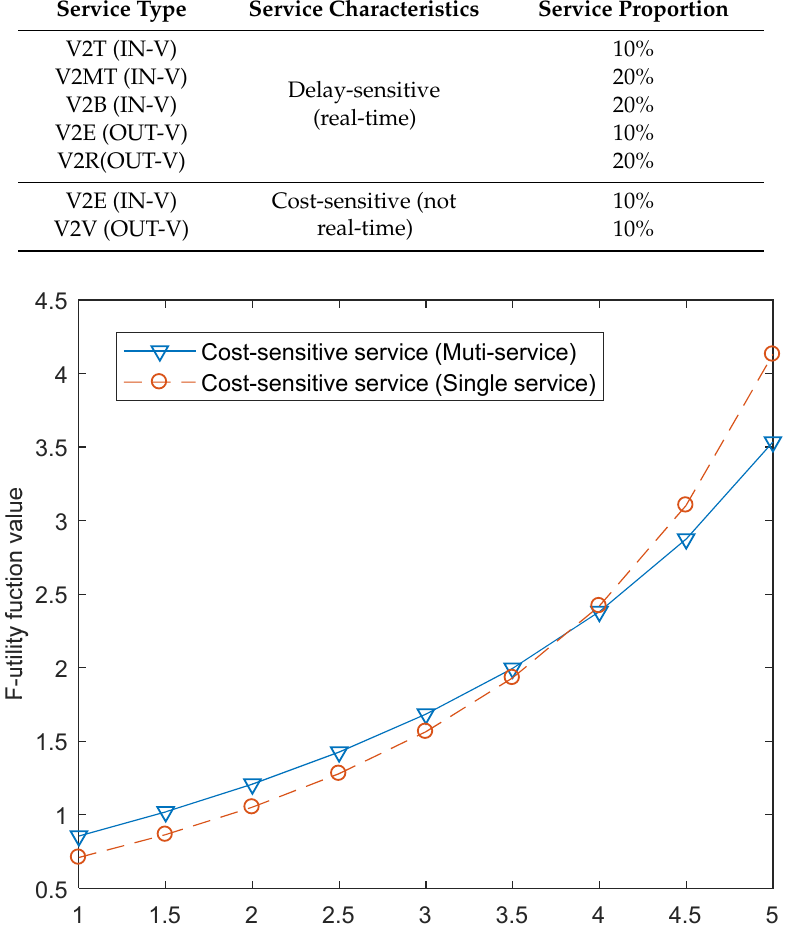
Figure 7. Delay-sensitive service utility value comparison